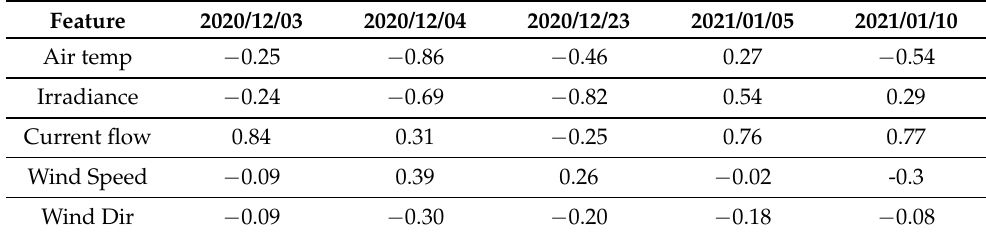
Table 2. Pearson correlation coefficient between the error of the IEEE 738 standard and the input values, for period with critical errors. Dates are in the format